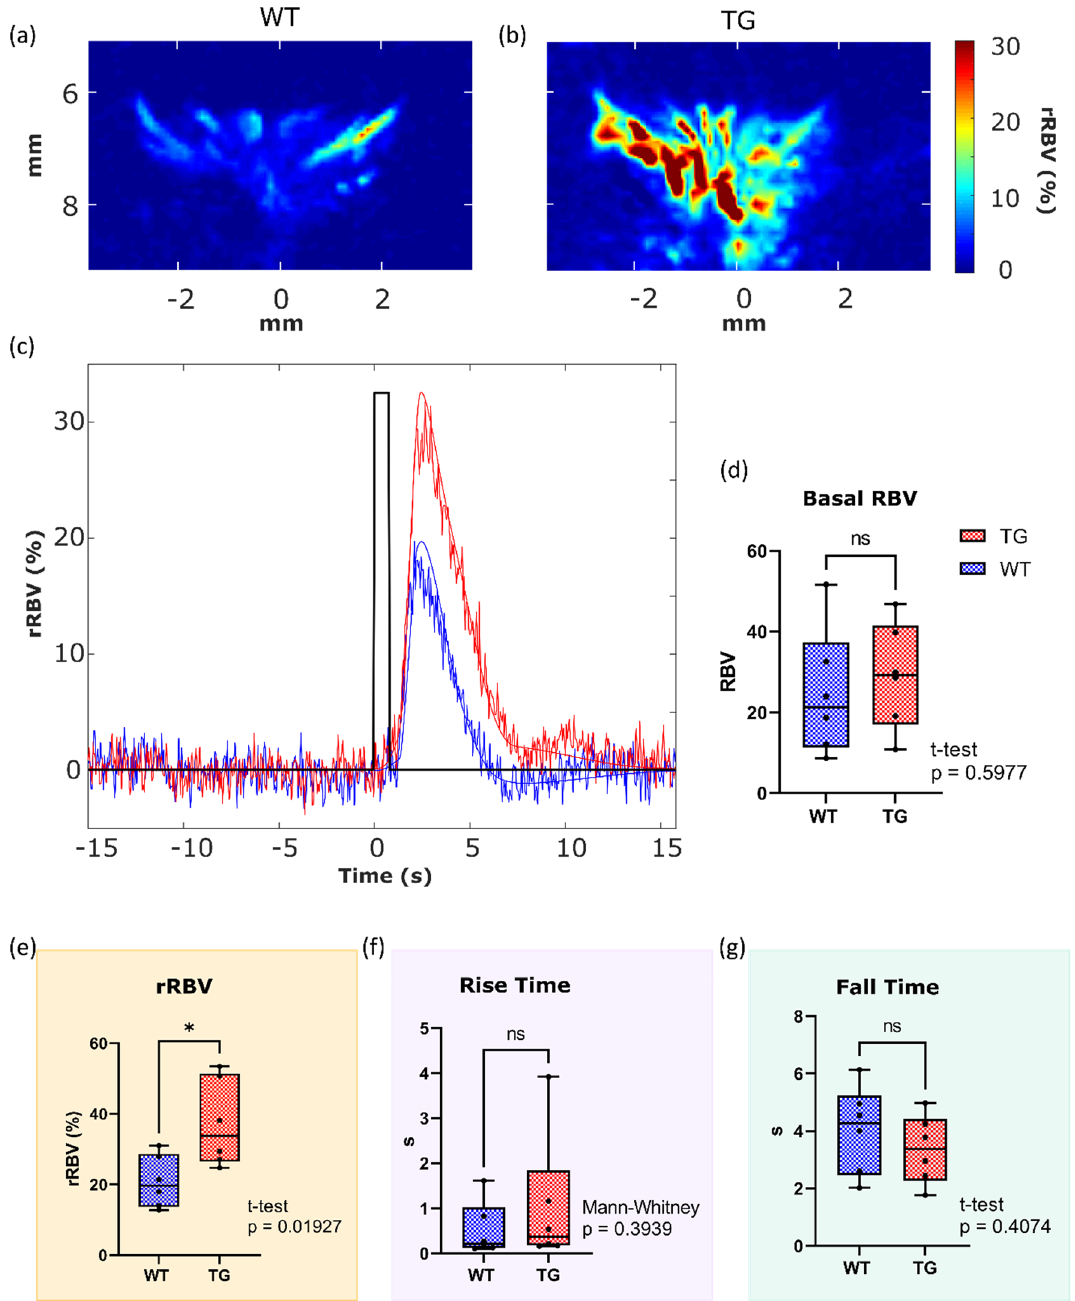
Figure 5. Changes in the eye neurovascular coupling in the TgF344-AD rat model. ( a ), ( b ) Example activation maps in a WT and in a TG animal. ( c ) Examples of trial-averaged eye neurovascular responses in a WT animal (Blue) and a TgF344-AD rat (red), illustrating the greater amplitude in the transgenic animal. ( d )–( g ) quantification of the different parameters of the eye neurovascular responses showing an increased response amplitude with an average of 20.83% for WT and 37.25%for TG ( e ). There was no significant difference in the basal blood volume (panel d ), the rise, and the fall time (panels f and g